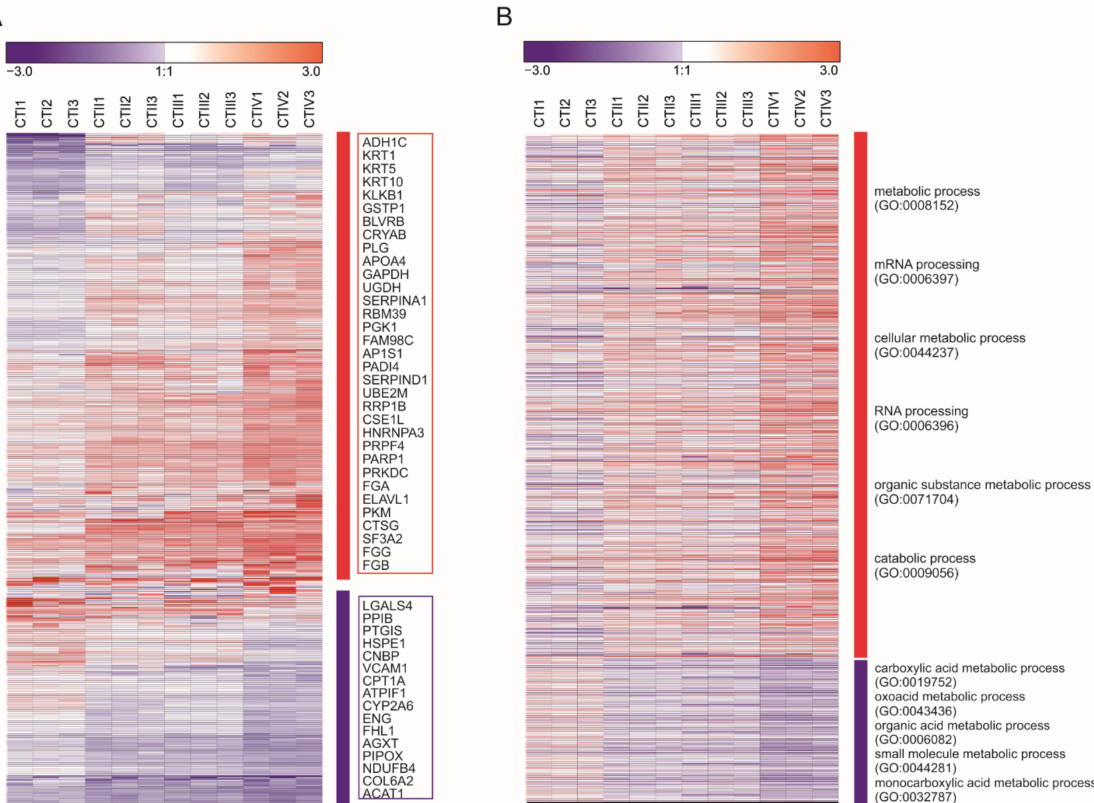
Figure 1. Proteome changes during tumor progression. ( A ) Hierarchal molecular clustering of 509 dysregulated (1.5-fold up or down regulation) proteins in tumors of different HCC subtypes. Each column represents a pool of patient samples, and rows indicate proteins. Up- and downregulated proteins were compared to the peritumoral tissue, respectively. The red frame surrounds the proteins whose upregulation was significantly associated with larger tumor sizes ( p < 0.001), while the purple frame surrounds proteins whose downregulation was significantly associated with bigger tumor sizes ( p < 0.001). ( B ) An enriched analysis of the Gene Ontology Biological Processes (GOBP) using protein panels based on upregulated and downregulated proteins to generate top-term significant biological process. Each column represents a pool of patient samples, and rows indicate proteins involved in that particular biological process. Cells are colored according to their Z-score (log2 of the relative protein abundance). The analysis was performed on the HCC cancer tissue proteome dataset from a previous work